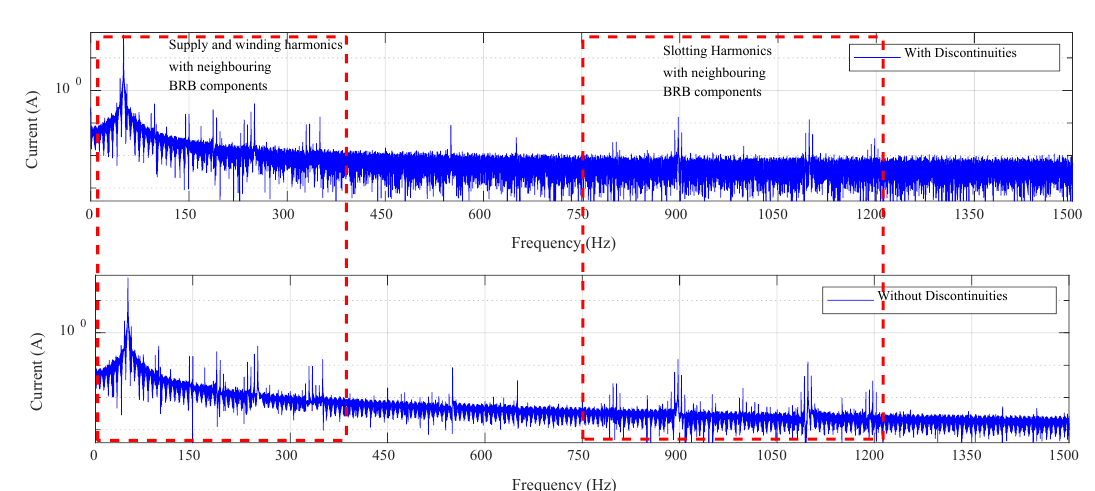
Figure 12. The practical stator current spectrum showing stator winding, slotting, and broken rotor bar-based harmonics with and without discontinuities.